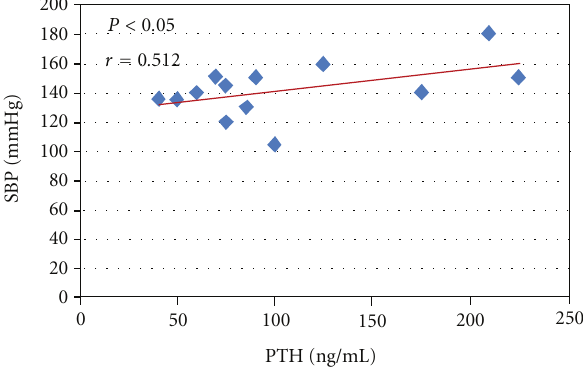
Figure 2: Linear correlation in PHPT patients between PTH levels